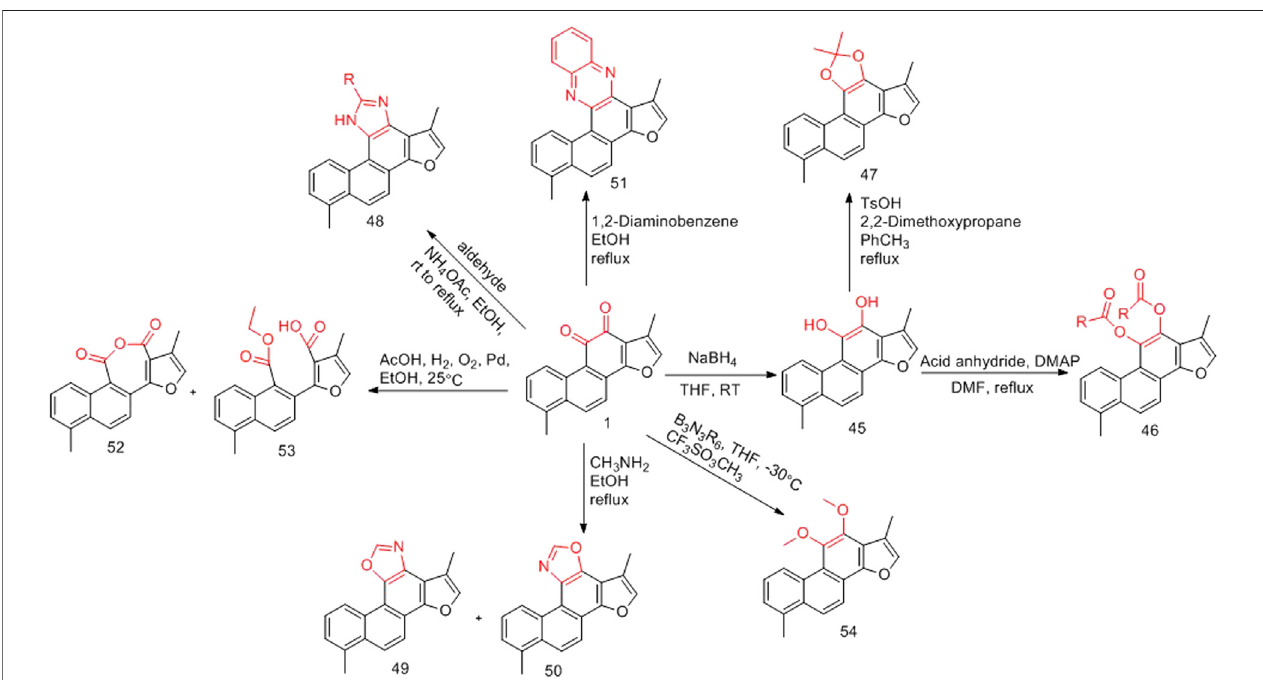
FIGURE 6 | Structural modi fi cation of o -quinone sites.